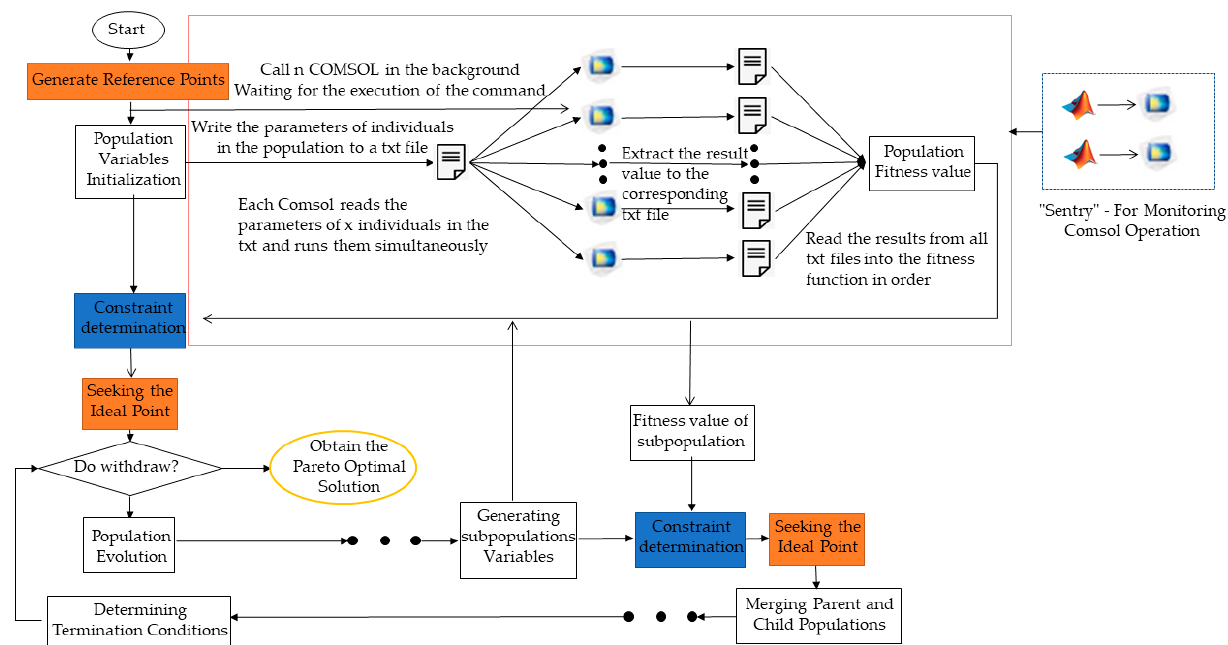
Figure 8. Joint parallel simulation method under many-objective optimization.